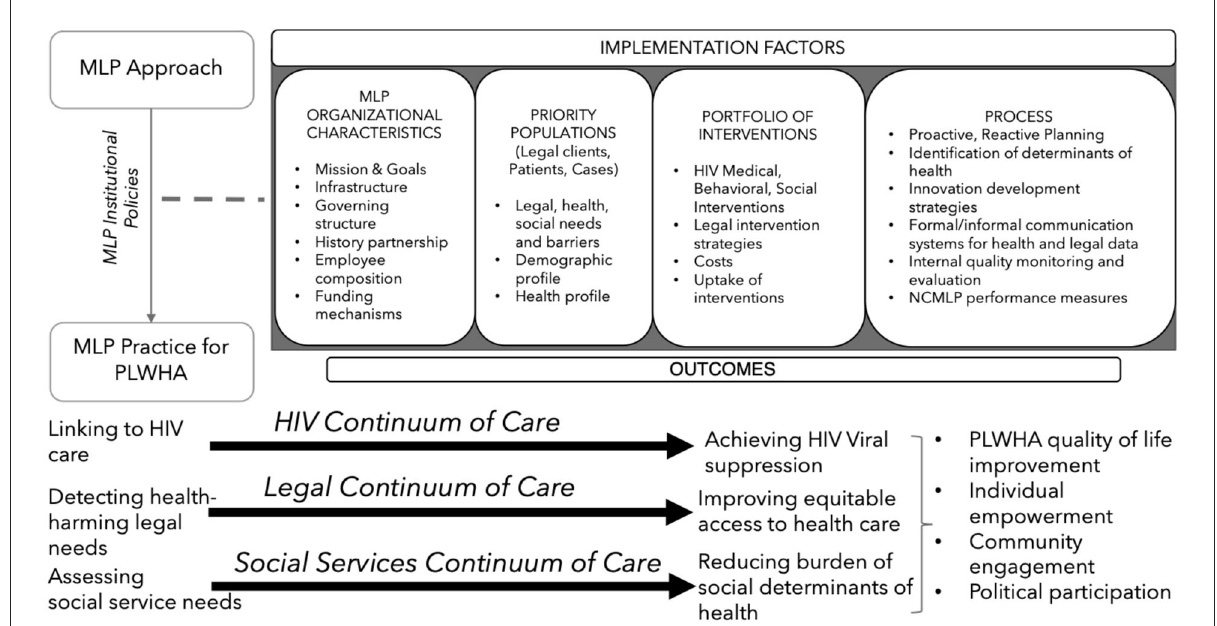
FIGURE1 Theoretical Framework. In building the structure used to present this theoretical framework for integrated continua of care, investigators referenced McRobie et al.